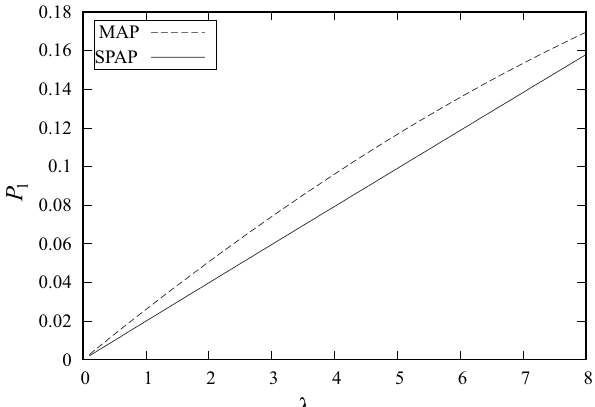
Figure 3. Dependence of the probability P 1 that a customer meets the server, having status 1 upon arrival, on the average arrival rate λ .